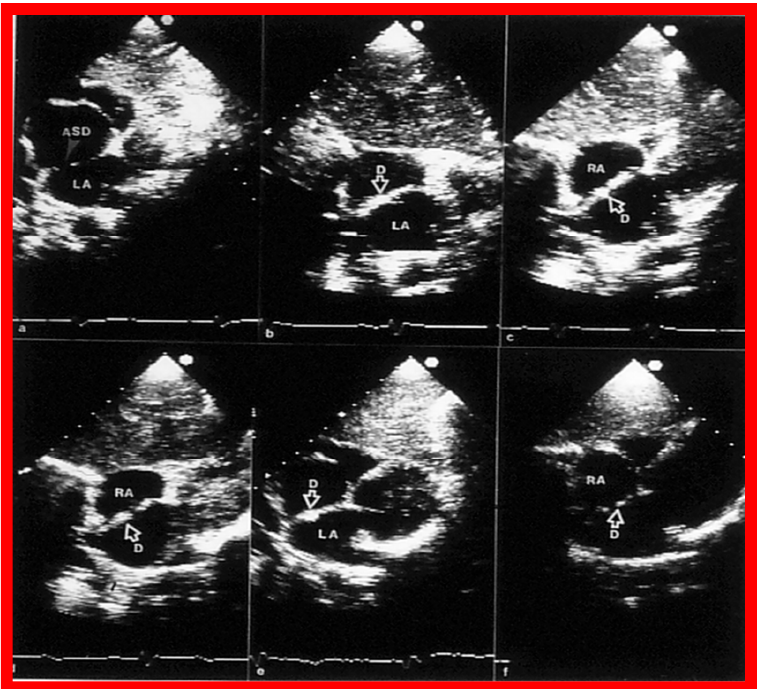
Figure 42. Two-dimensional echocardiographic images in the subcostal projections of the atrial septal defect (ASD) in long-axis views before ( a ), shortly following ( b ), and at one ( c ), six ( d ), twelve ( e ), and twenty-four ( f ) months after ASD occlusion demonstrating the outcome of percutaneous occlusion of an atrial defect with buttoned device. Stable position of the device (D) on the atrial septum ( b – e ) is seen. Twenty-four months later ( f ), the device components look to be incorporated into the atrial septal tissue. On pulsed and color Doppler studies simultaneous with 2D examination, no residual shunt was seen (not shown). LA, left atrium; RA, right atrium. Replicated from Refer- ence [60].